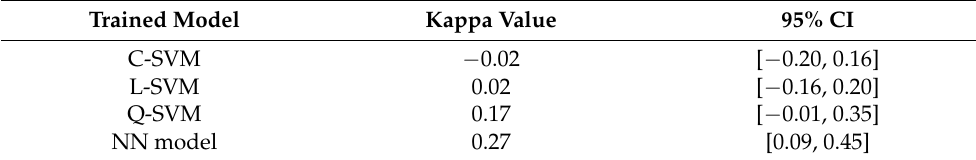
Table 3. Interrater reliability (IRR) values and confidence interval (CI) 95% for each classifier. Trained